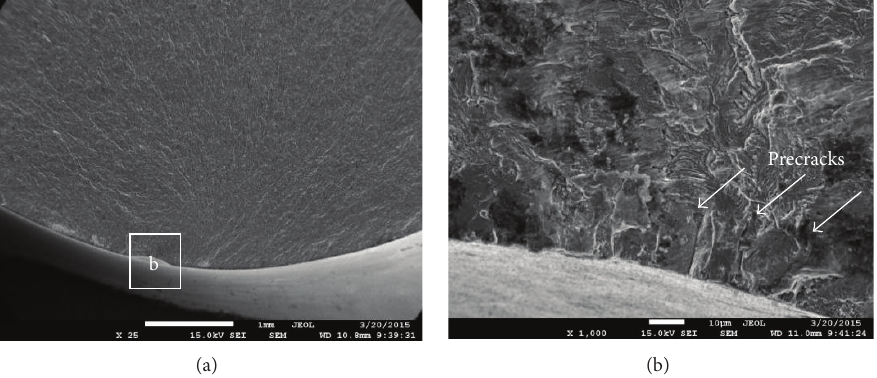
Figure 10: Fracture surface of the indented CN: (a) fracture surface and (b) crack initiation site on the bottom of the indentation.